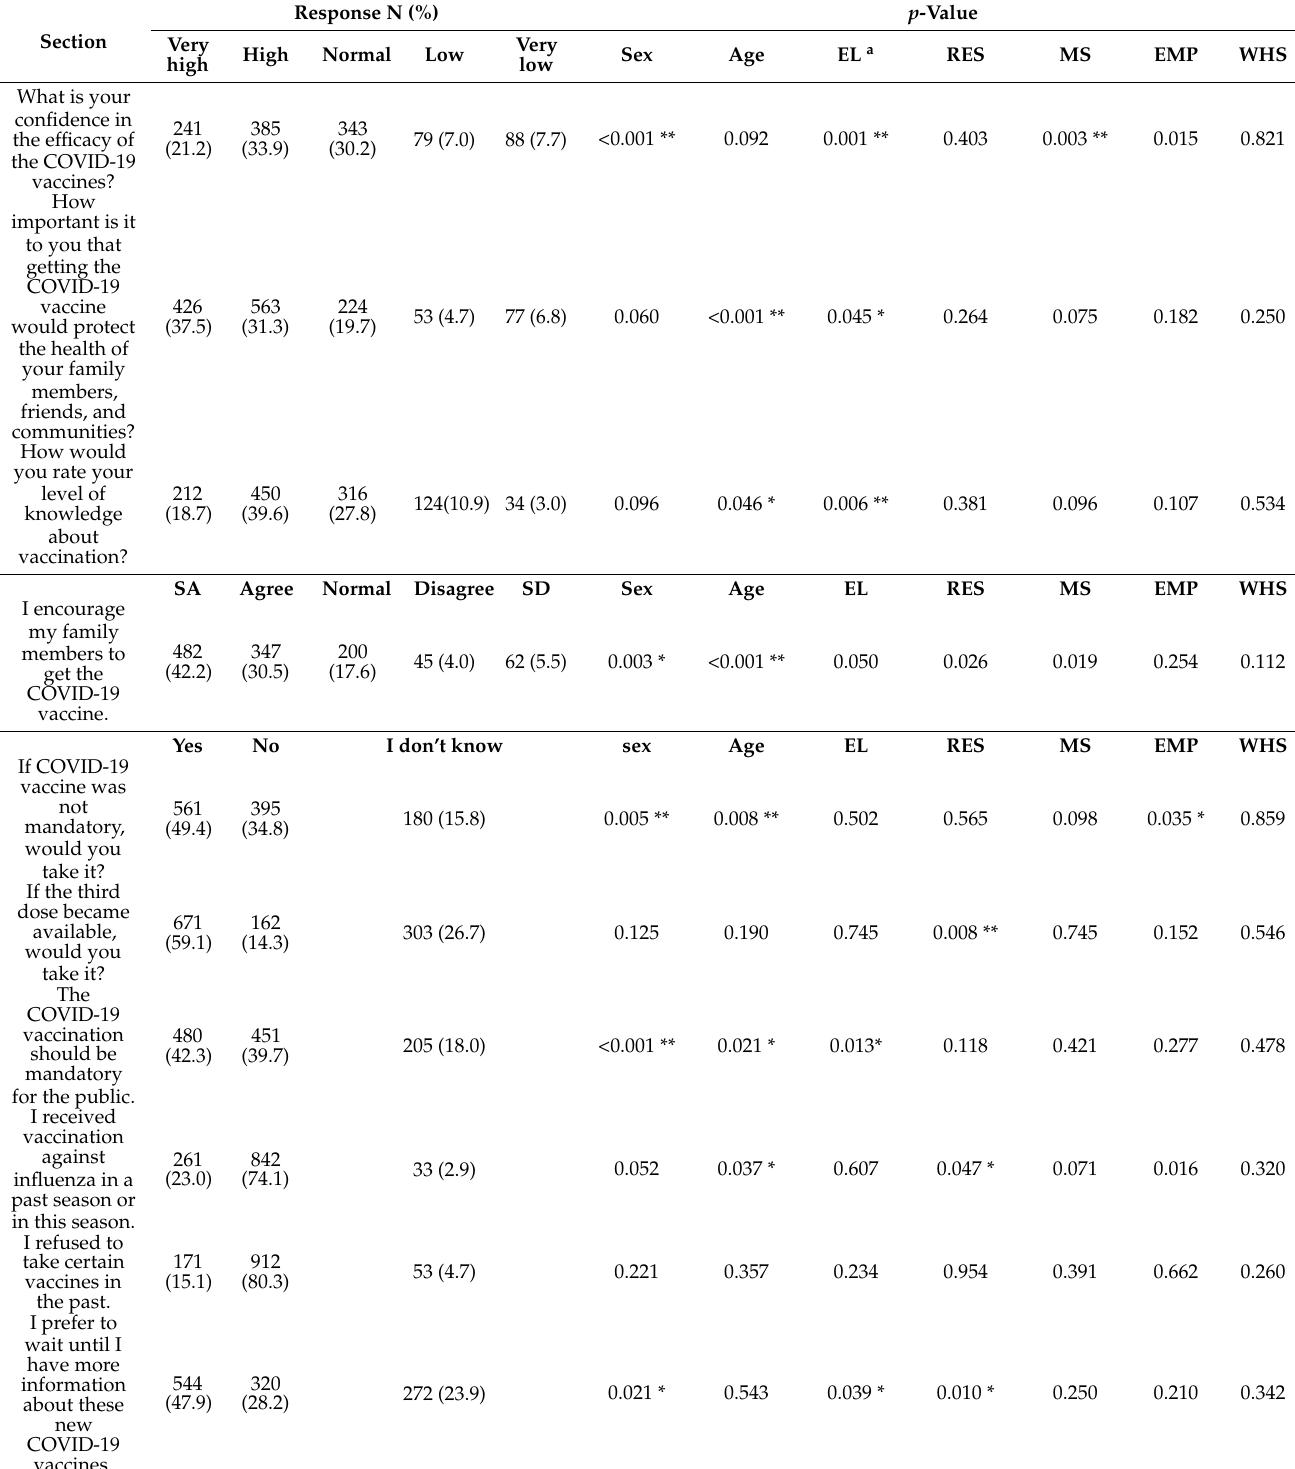
Table 4. Participants’ acceptance of COVID-19 and its